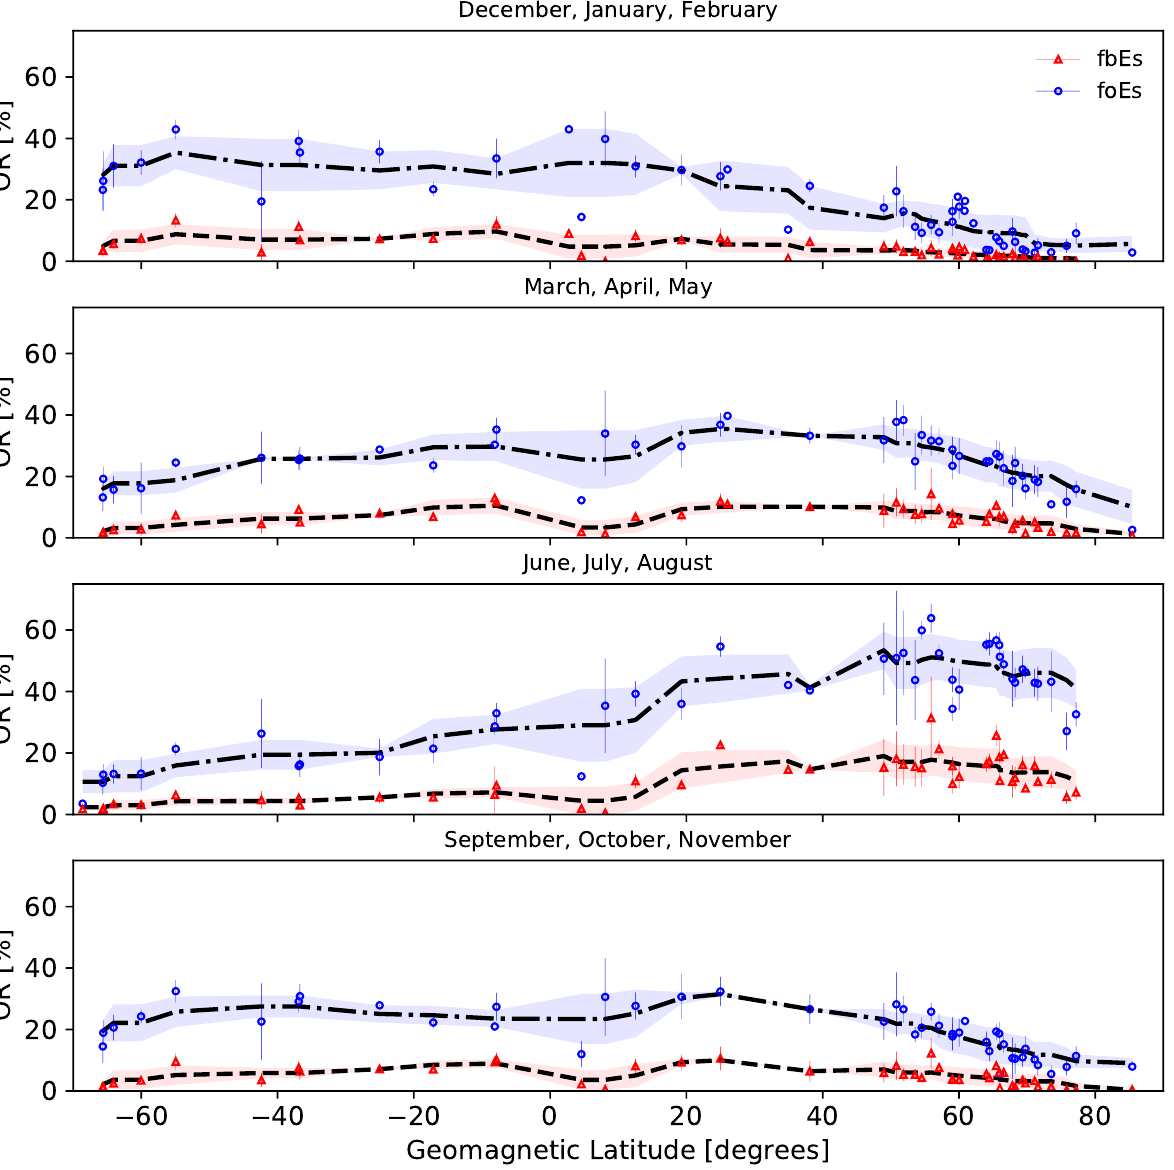
Figure 7. Occurrence rates for fbEs and foEs ≥ 3 MHz separated by geomagnetic latitude. Error bars correspond to the standard deviation of the yearly averages taken over all years with sufficient data. The trend lines and shading correspond to spatial running averages and standard deviations calculated with a ± 10 ◦ window,